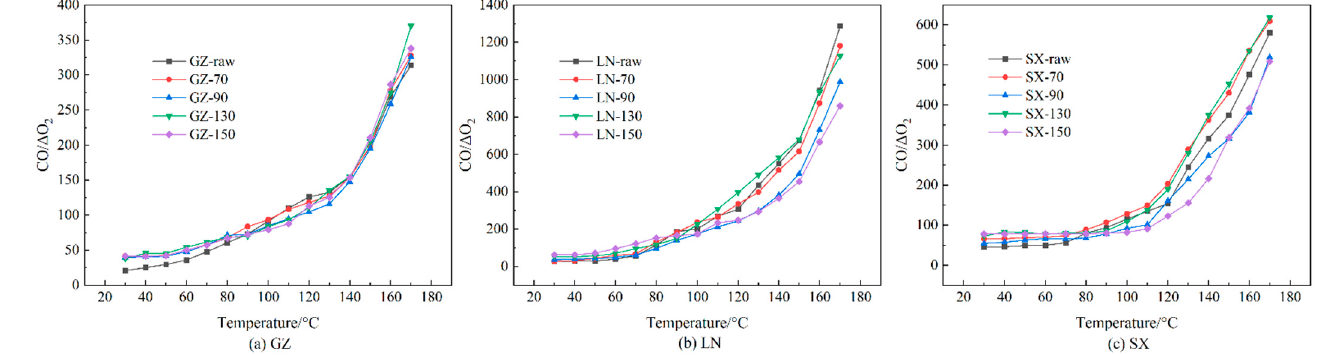
Figure 5. CO/ Δ O 2 behaviors of different coal types: (a) GZ; (b) LN; (c) SX. Figure 5. CO/ ∆ O 2 behaviors of different coal types: ( a ) GZ; ( b ) LN; ( c )